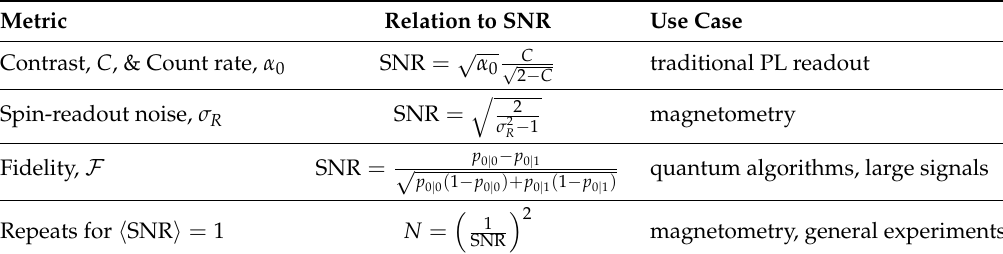
Table 1. Compilation of spin-readout metrics, their formal relation to differential SNR, and common use cases. PL, photoluminescence; SNR, Signal-to-noise